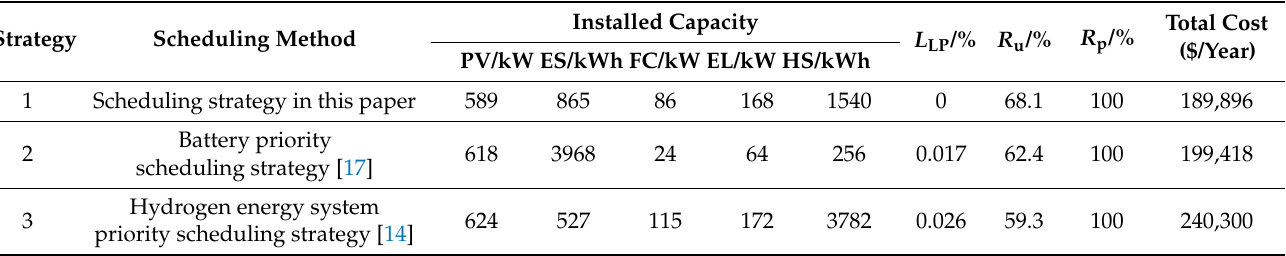
Table 2. Optimized configuration results of source and storage